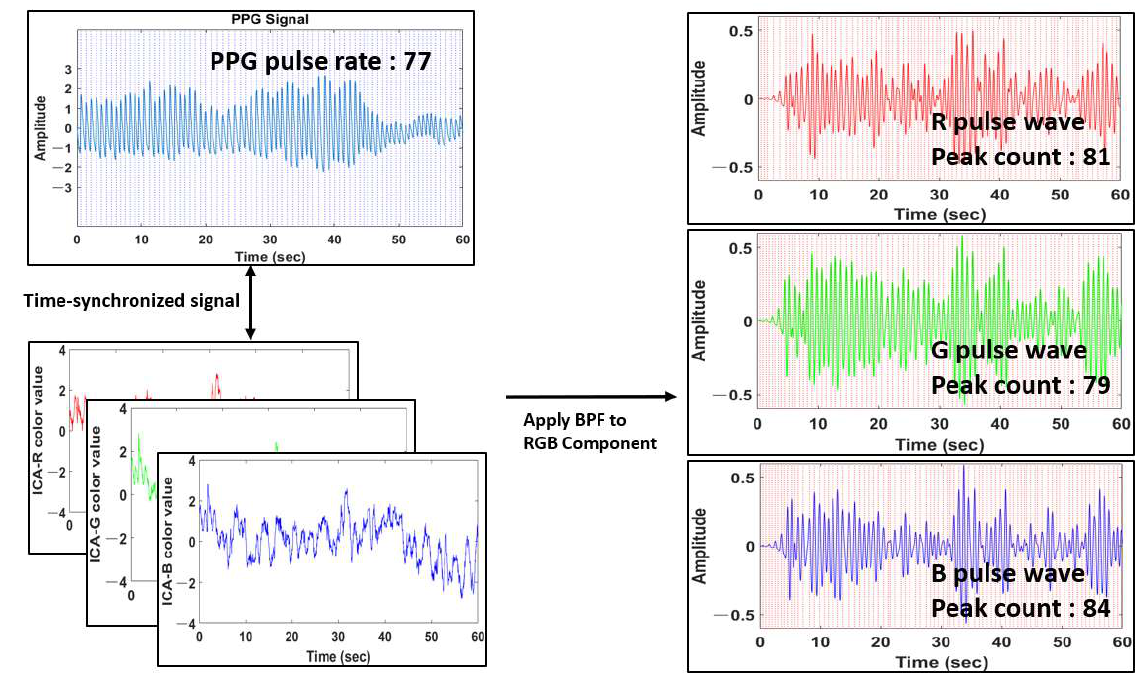
Figure 15. R, G, B pulse waves calculated by applying BPF to the RGB component.